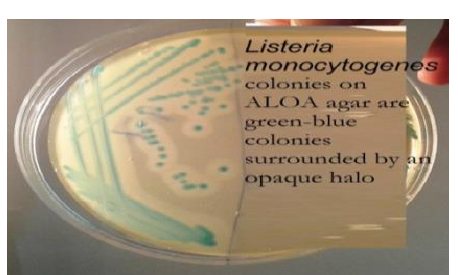
as shown in figure5 Figure (2): The red curves indicate multiplication of Listeria monocytogenes DNA.